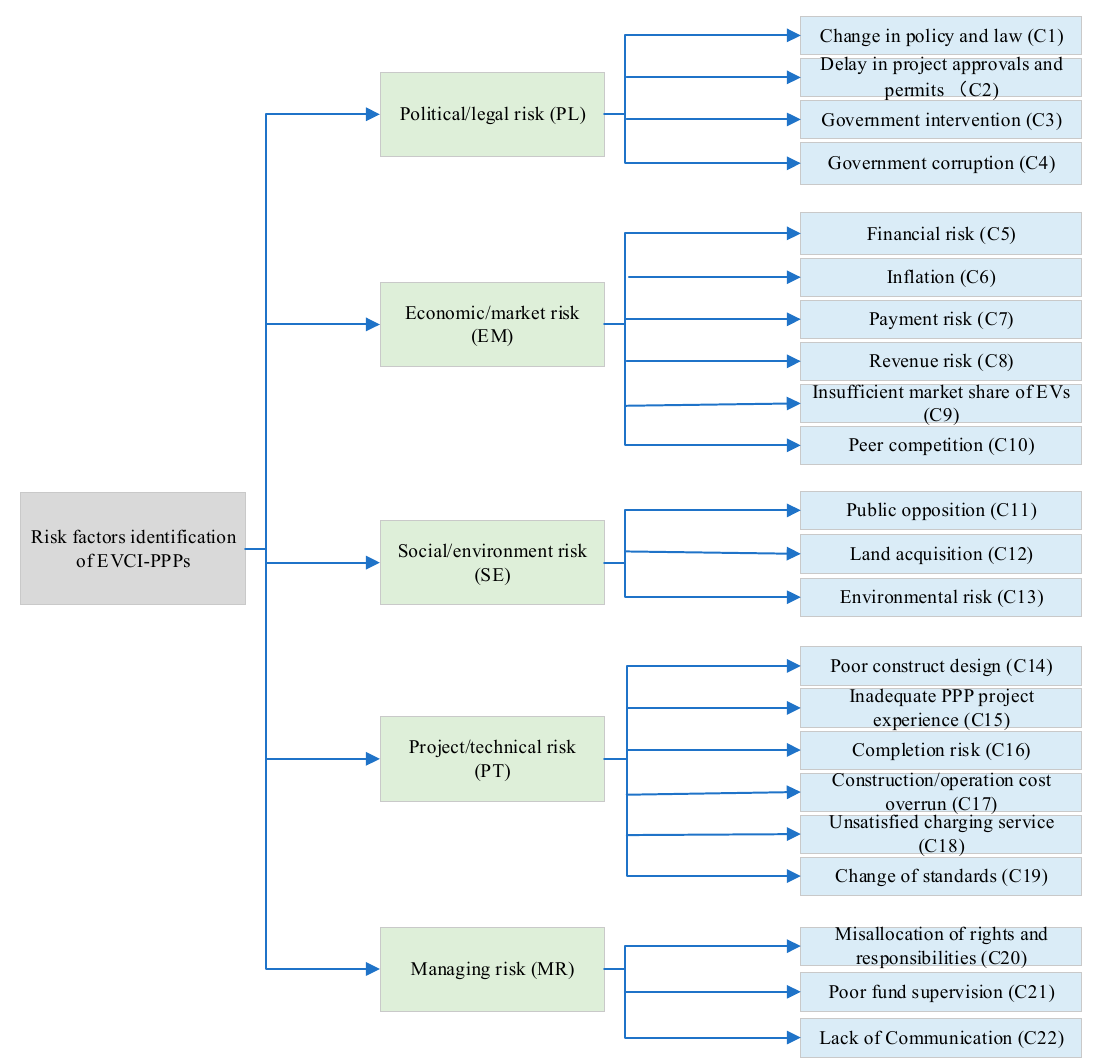
Figure 2. The risk factors of electric vehicle charging infrastructure public–private partnerships (EVCI-PPPs) in